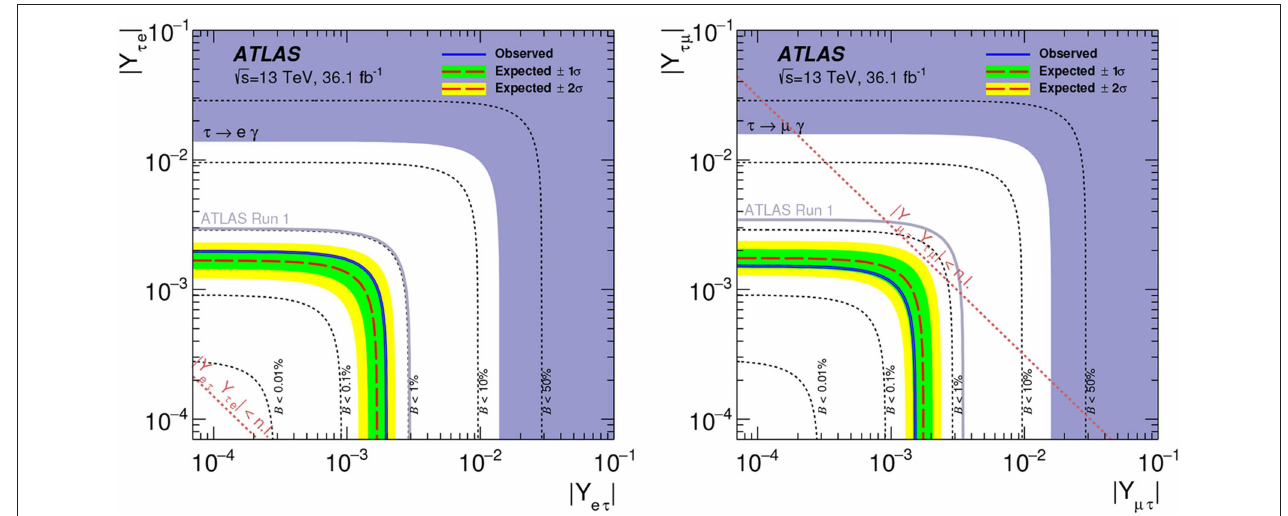
FIGURE 4 | Upper limits on the absolute value of the couplings Y τℓ and Y ℓτ together with the limits from earlier ATLAS analyses [39, 57] (light gray line) and the most ℓγ searches (dark purple region). Also indicated are limits corresponding to different branching fractions (0.01, 0.1, 1, 10, and 50%) stringent indirect limits from τ → and the naturalness limit (denoted